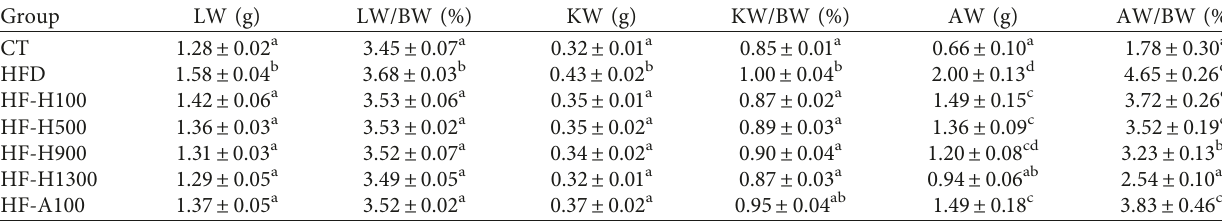
Table 3: Weight of tissues after 6 weeks of the experiment.